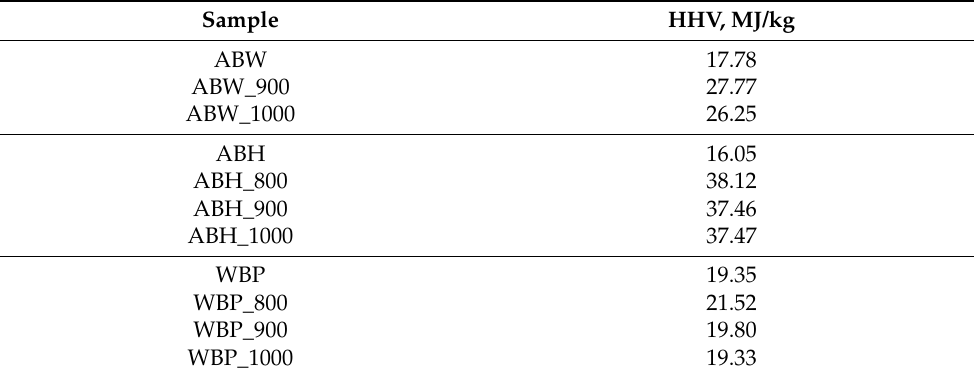
Table 2. Higher heating value of studied samples.